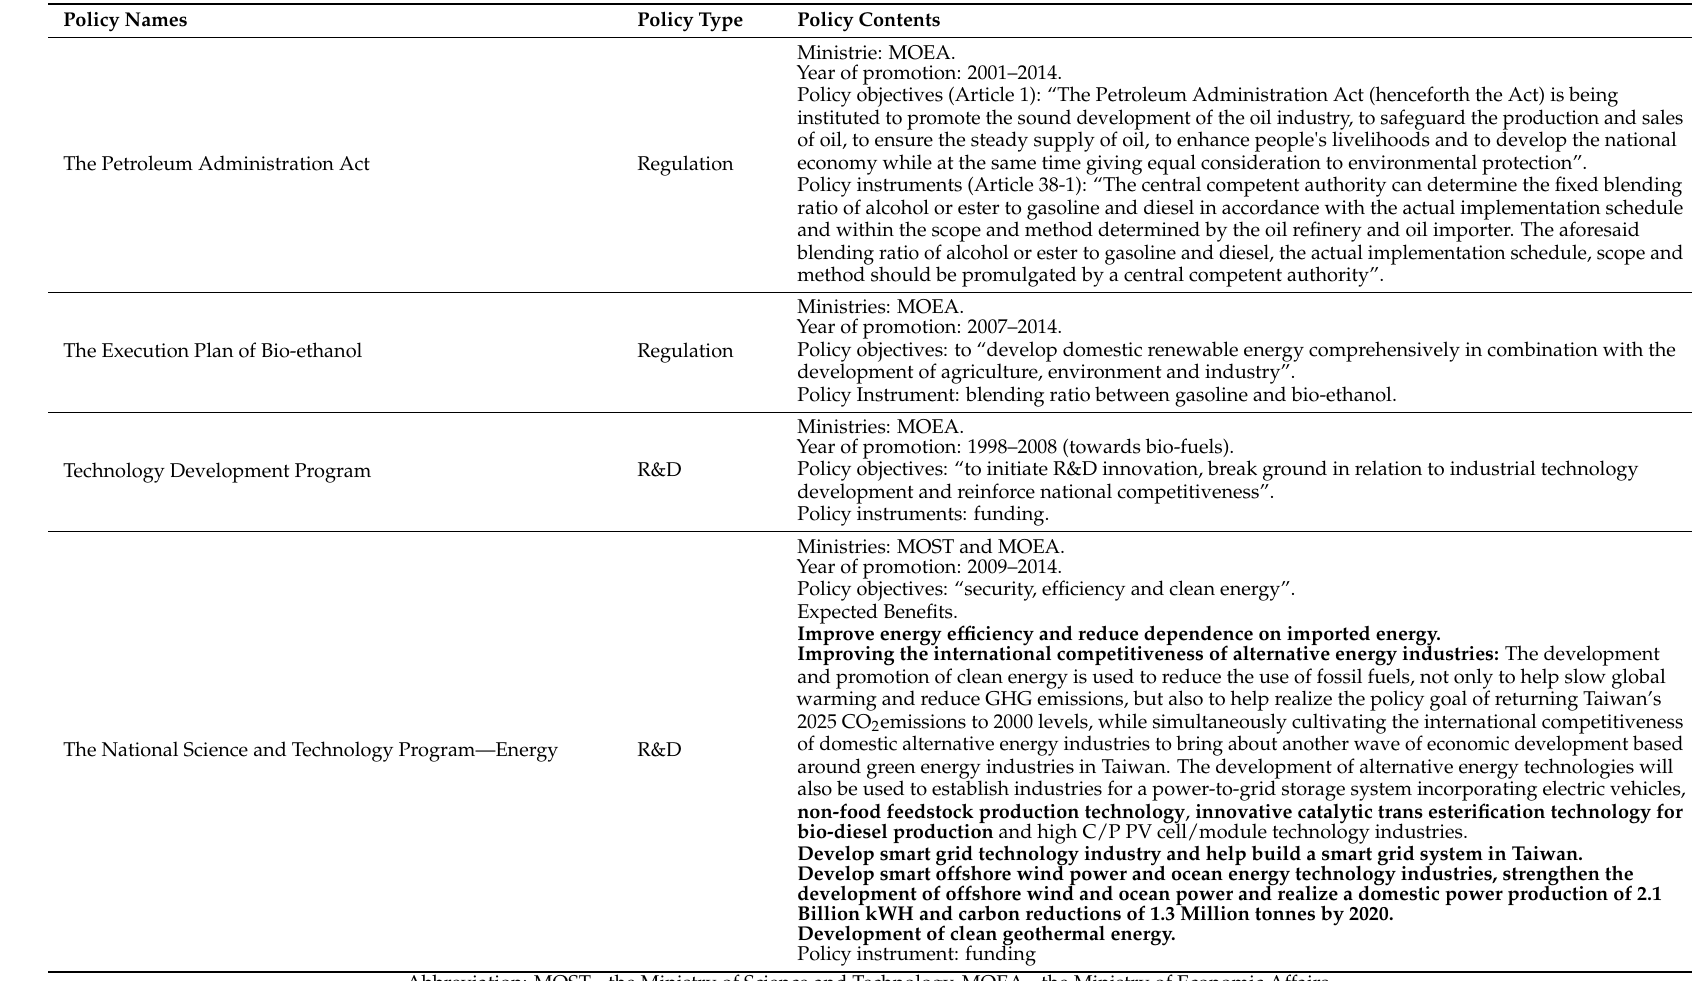
Table 5. Detailed content of regulations and R&D